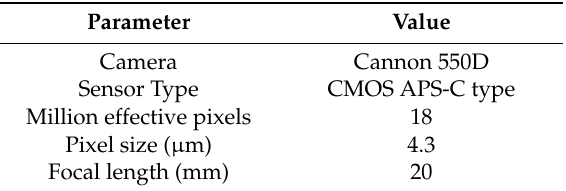
Figure 2. ( a ) Diagram showing the stereo-camera baseline setting and the location of the total station (TS) prism; ( b ) diagram showing the configuration of the cameras from a top down view. x , y and z refer to the coordinates of the focal point (P); and ( c ) diagram depicting the stereo-camera on the adjustable monopod with an approximate indication of the heights tested in the calibration study. Table 3. Camera characteristics.